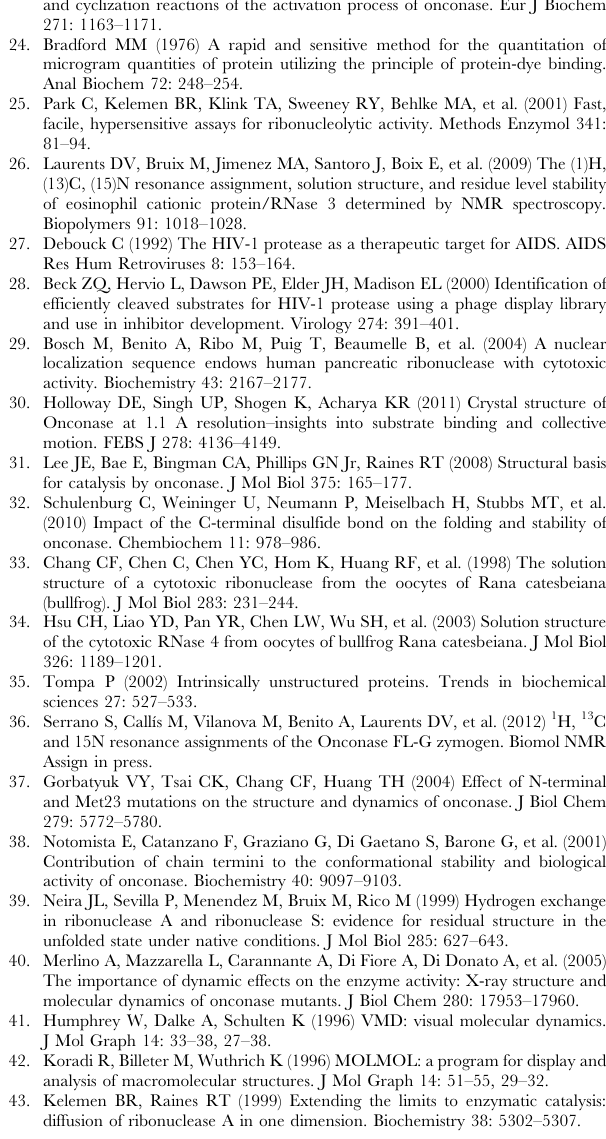
Figure S3 Structure of the ONCFLG variant showing the linker region, active site residues and disulfide bonds. The different conformations of the linker region Gly33-Gly38 are shown in orange while the rest of the molecule is shown in grey ribbon. Phe40-Leu41, that constitute the scissile bond are shown in red, Ser49, Lys57 and Phe26 are colored in blue and His58, Lys79 and His25 are in purple. This representation was generated using VMD [41].